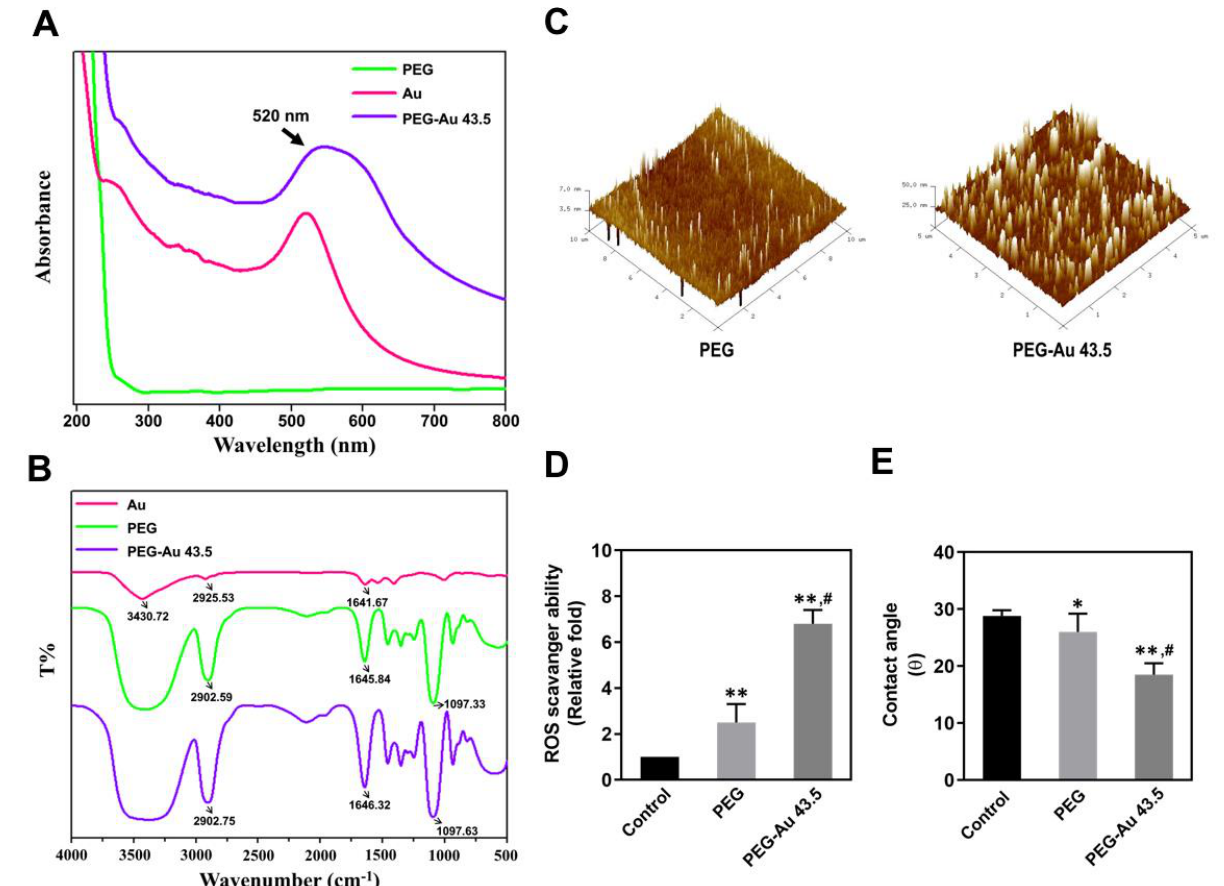
Figure 1. Material characterization. ( A ) The UV-Vis spectra of pure PEG, pure Au, and PEG – Au 43.5 ppm. The absorbance peak at 520 nm evaluated the presence of Au nanoparticles for pure Au and PEG combined with 43.5 ppm of Au. ( B ) The FTIR spectra of Au nanoparticles, pure PEG, and PEG – Au 43.5 ppm. ( C ) The AFM topography of 3D images for pure PEG and PEG – Au 43.5 ppm nanocomposites. ( D ) The free radical scavenging ability of pure PEG and PEG – Au 43.5 ppm. The ROS scavenging ability of pure PEG is slightly better than the control. However, the PEG – Au 43.5 ppm group demonstrated the greatest scavenging ability. Deionized water represented as the control group. ( E ) The hydrophilicity property of PEG and PEG – Au 43.5 ppm was investigated. The semi-quantitative results of the average water contact angle ( θ ) evaluated that PEG – Au 43.5 ppm was the lowest. The contact angle without water was θ = 0 °. Pure Au nanoparticles were represented as the control group. Data are represented as mean ± SD (n = 3). * p < 0.05, ** p < 0.01: compared to the control group. # p < 0.05: compared to the pure PEG group.